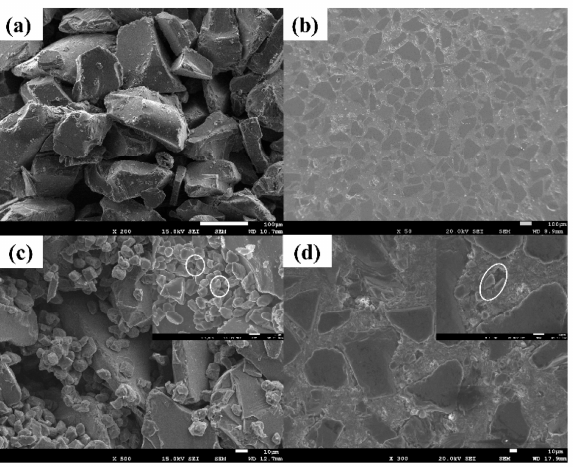
Figure 3. Representative SEM images showing the micromorphology of the SiC preforms and the corresponding SiC/Al composites with coarse to fine particle ratios of ( a , b ) 1:0 and ( c , d )